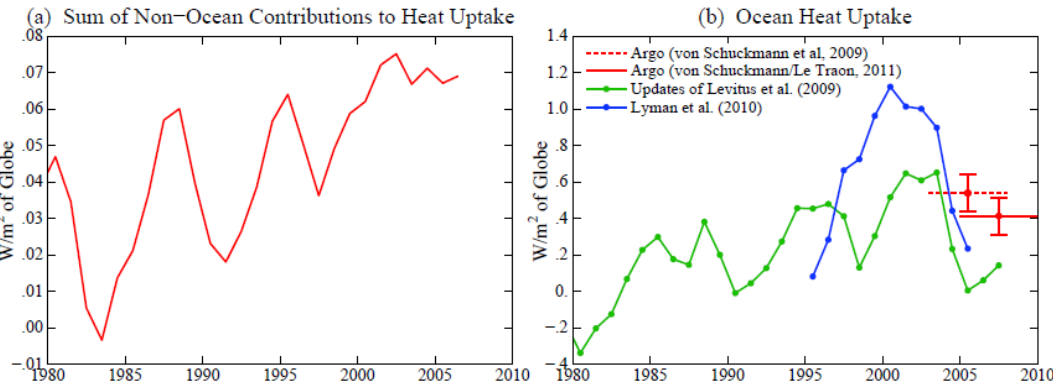
Fig. 9. (a) Sum of non-ocean contributions to planetary energy imbalance from Fig. 8, (b) Six-year trends of ocean heat uptake estimated by Levitus et al. (2009) and Lyman et al. (2010) for upper 700 m of the ocean, and estimates based on Argo float data for the upper 2000 m for 2003-2008 and 2005-2010.